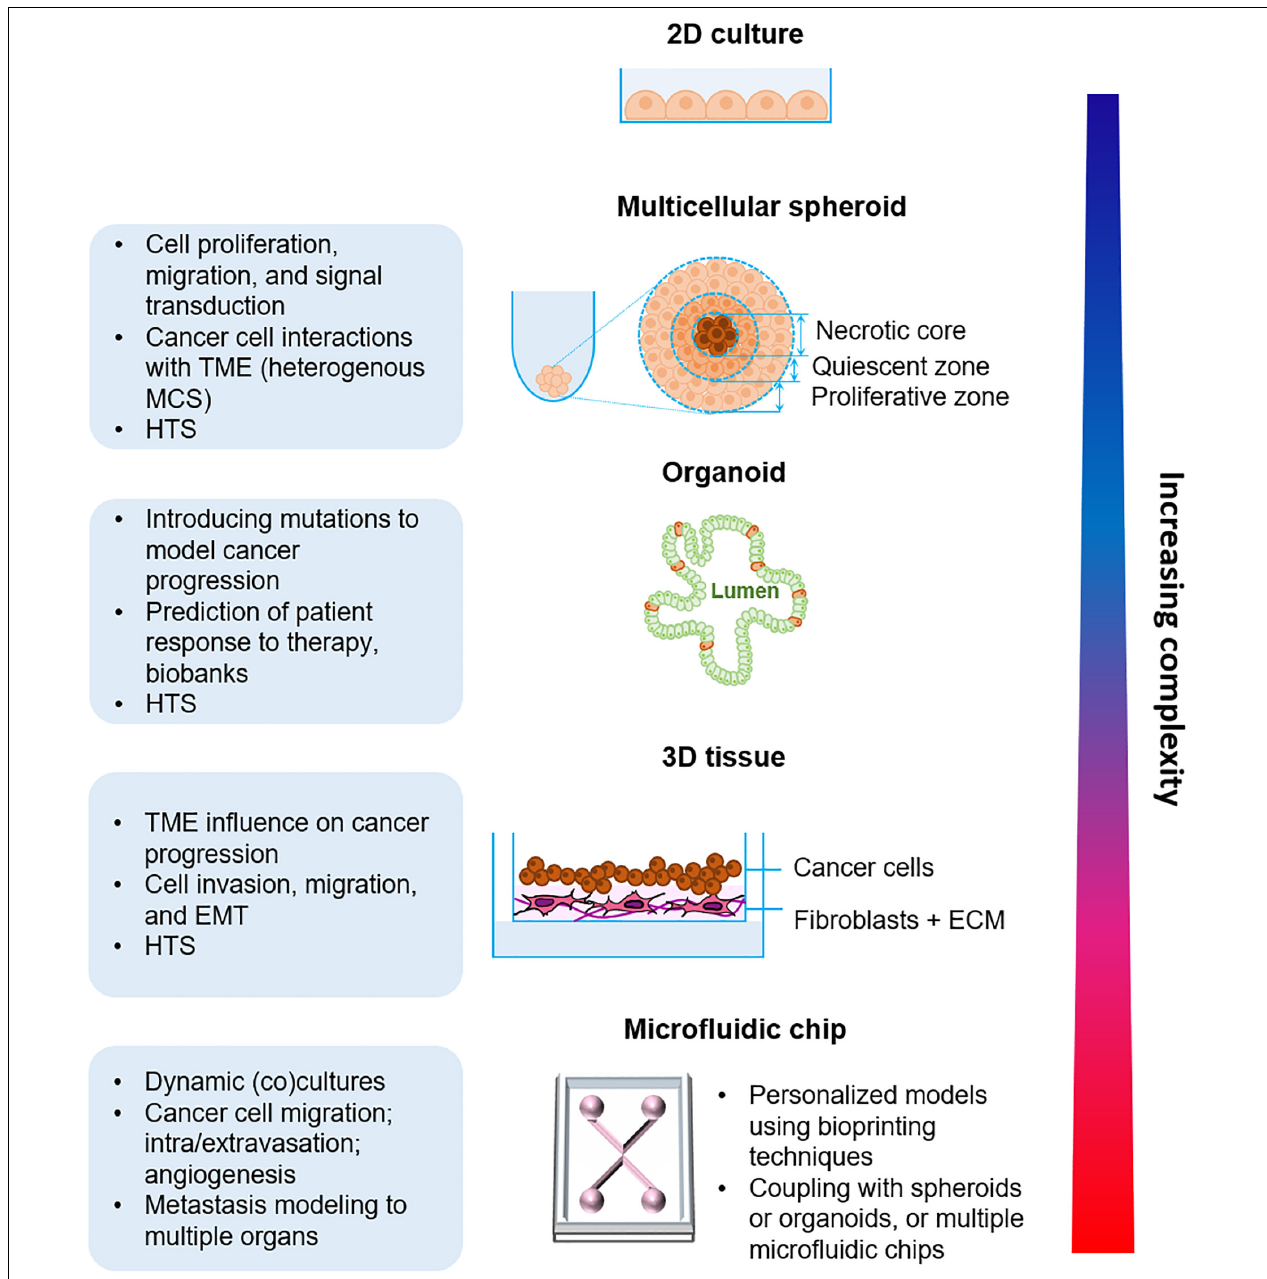
FIGURE 2 | Organotypic in vitro models of cancer progression with increasing biological complexity from the simple multicellular spheroid model to the more complex microfluidic approaches. TME, Tumor microenvironment; MCS, Multicellular spheroid; HTS, High-throughput screening; ECM, Extracellular